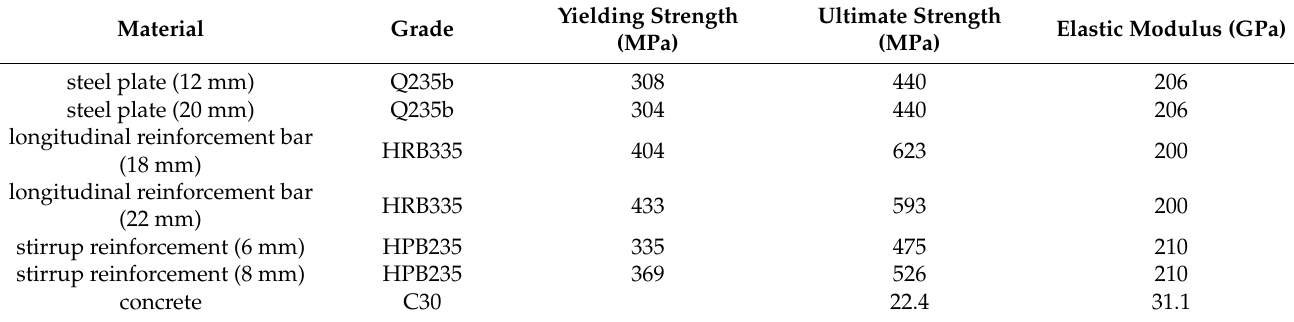
Table 2. Measured results of material